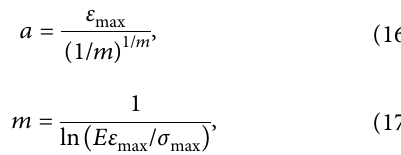
Figure 4. The other 4 parameters can be obtained by fitting with the experimental curves. The fitting results are shown in Figure 9. All the parameters of the dynamic constitutive model of frozen fractured sandstone are listed in Table 2.